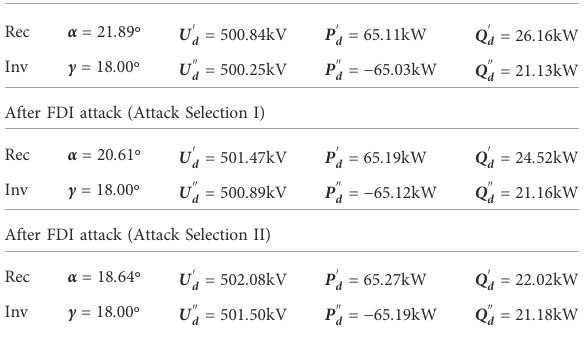
TABLE 8 Operating conditions of the DC transmission line before and after FDI attacks. Before FDI